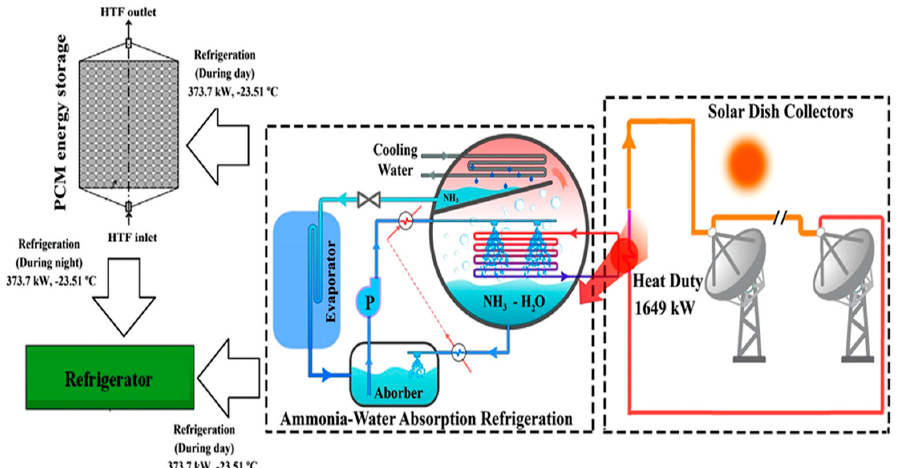
Figure 9. Sketch of solar refrigerator flow diagram with PCM (Ghorbani and Mehrpooy, [75]).